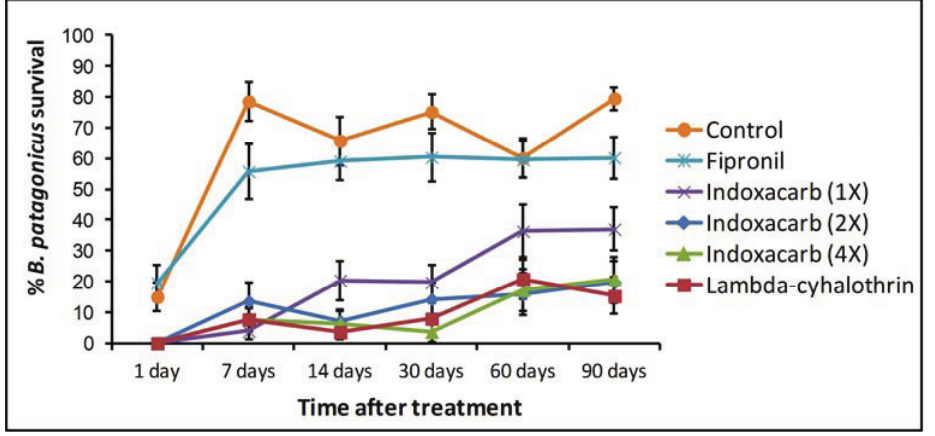
Figure 1. Change in insecticidal activity over time. This comparison is based on the mean ant survival at 5 days after exposure. Error bars were constructed with the standard error of the mean.